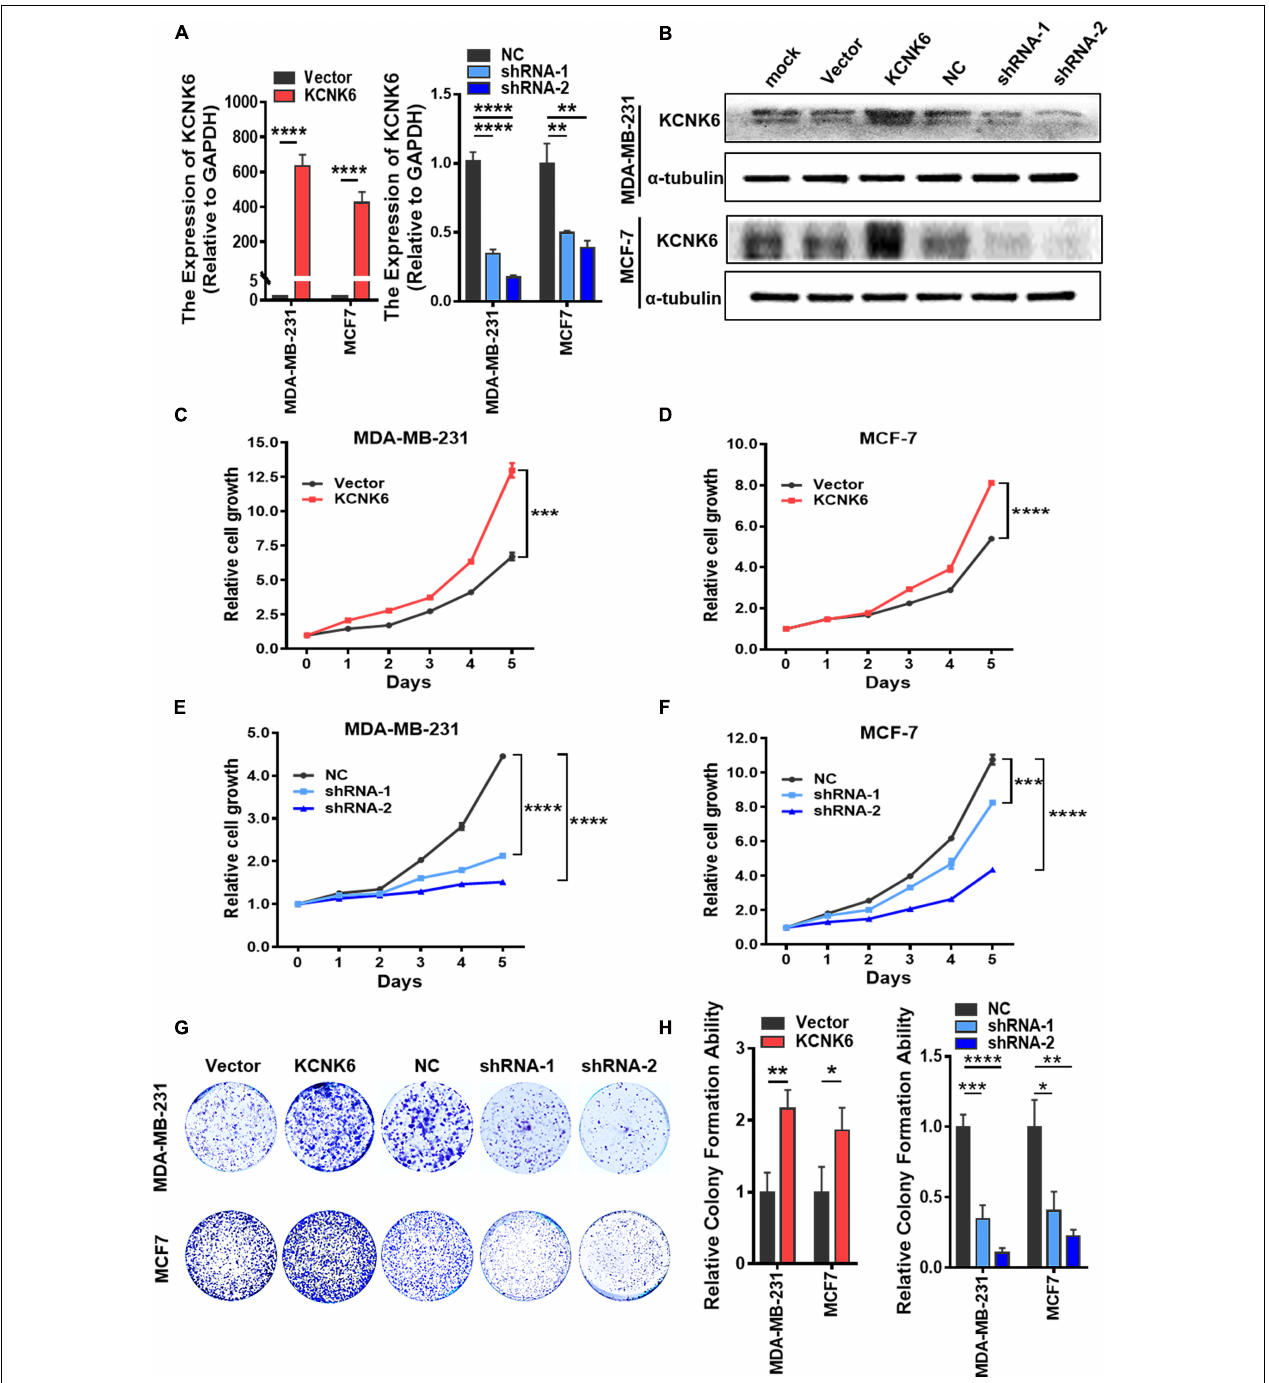
FIGURE 2 | KCNK6 expression affects breast cancer cell proliferation. (A) qRT-PCR assay was used to detect the overexpression and knockdown efficiency of KCNK6 in MDA-MB-231 cells and MCF-7 cells. (B) Western blot assay was used to detect the overexpression and knockdown efficiency of KCNK6 in MDA-MB-231 cells and MCF-7 cells. (C) MTT experiment showed that overexpression of KCNK6 could significantly promote the proliferation of MDA-MB-231 cells. (D) MTT experiment showed that overexpression of KCNK6 could significantly promote the proliferation of MCF-7 cells. (E) MTT experiment showed that knocking down KCNK6 could significantly inhibit the proliferation of MDA-MB-231 cells. (F) MTT experiment showed that knocking down KCNK6 could significantly inhibit the proliferation of MCF-7 cells. (G) Colony formation assay showed that overexpression of KCNK6 could significantly promote the proliferation of MDA-MB-231 cells and MCF-7 cells, while knocking down KCNK6 could significantly inhibit the proliferation of MDA-MB-231 cells and MCF-7 cells. (H) Statistical analysis of the number of clones in each group showed that overexpression of KCNK6 could significantly promote the proliferation of MDA-MB-231 cells and MCF-7 cells, while knock down KCNK6 to get the opposite result. * P < 0.05; ** P < 0.01; *** P < 0.001; **** P < 0.0001.